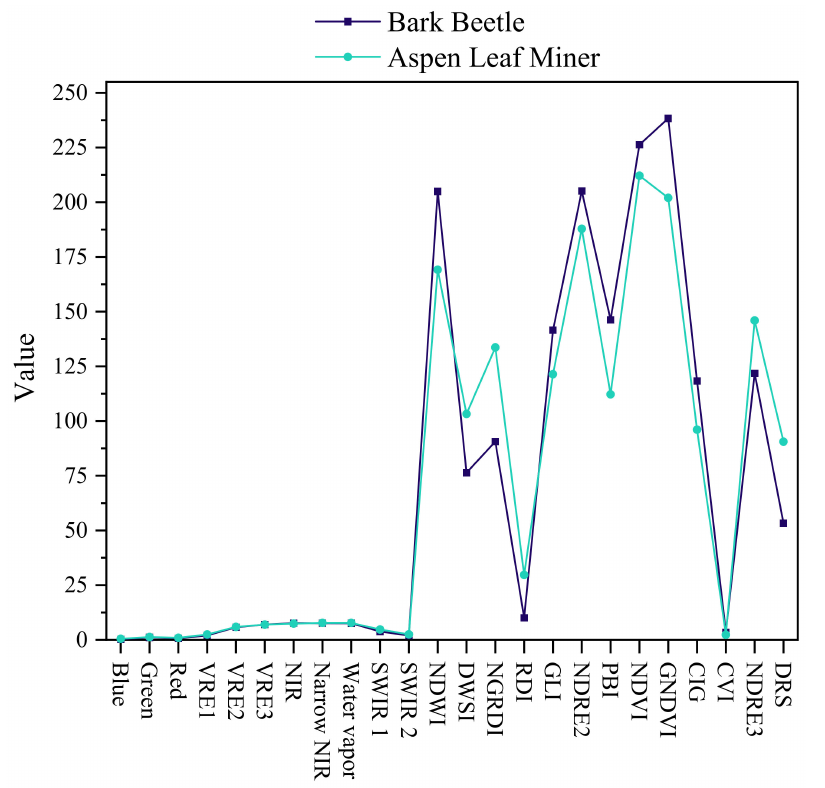
Figure 11. The spectral figure of bark beetle and aspen leaf miner. VRE represents Vegetation Red